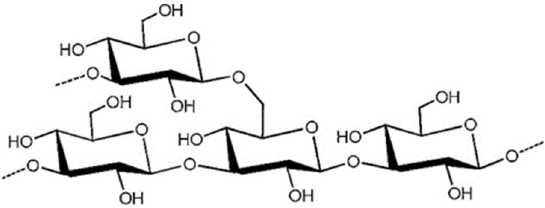
Figure 4. The presumptive structure of the laminaran. (Reprinted with permission from Ref. [61]. Copyright 2020, Elsevier).